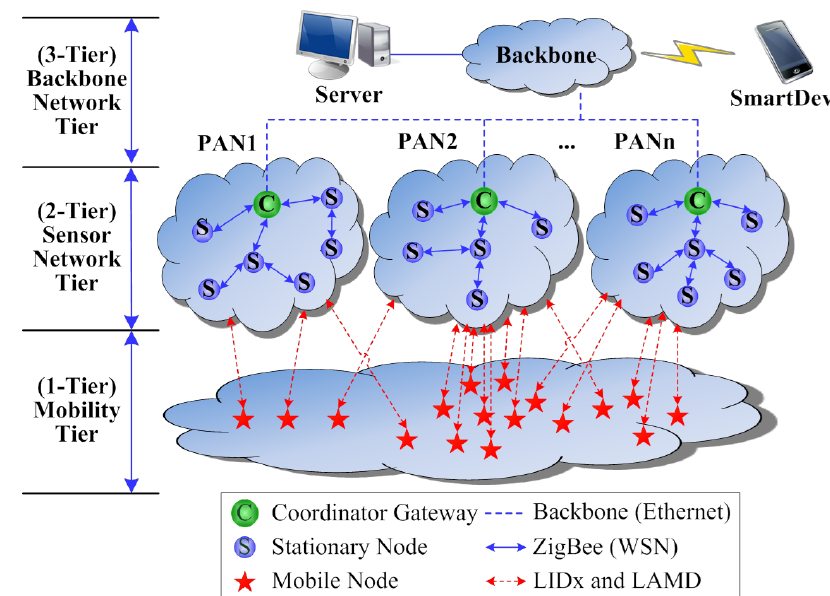
Figure 2. Proposed mobile-stationary co-existing WSN